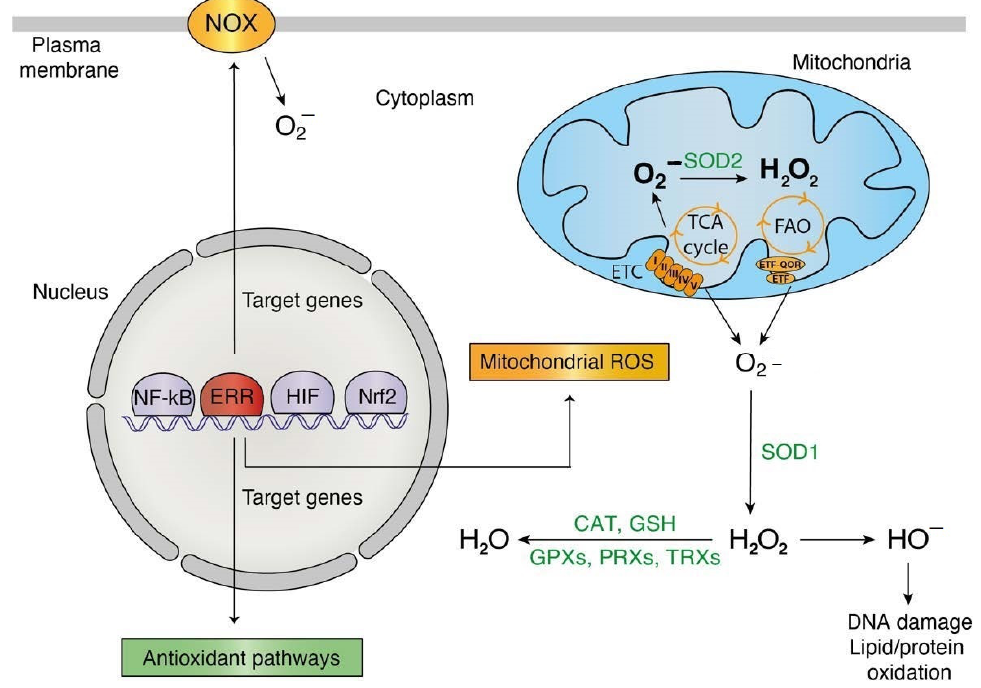
Figure 2. ERR pleiotropic roles in redox signaling. Orange: phenomena/actors implicated in ROS generation and transcriptionally targeted by the estrogen-related-receptors (ERRs). Green: phenomena/actors implicated in ROS detoxification and transcriptionally targeted by the ERRs. Abbreviations used: CAT, catalase; ETC, electron transport chain; FAO, fatty acid oxidation; GPX, glutathione peroxidase; GSH, glutathione; NOX, NADPH oxidase; PRX, peroxiredoxin; SOD, superoxide dismutase; TCA cycle, tricarboxylic acid cycle; TRX, thioredoxin.